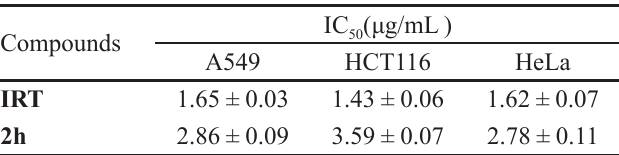
cervical carcinoma